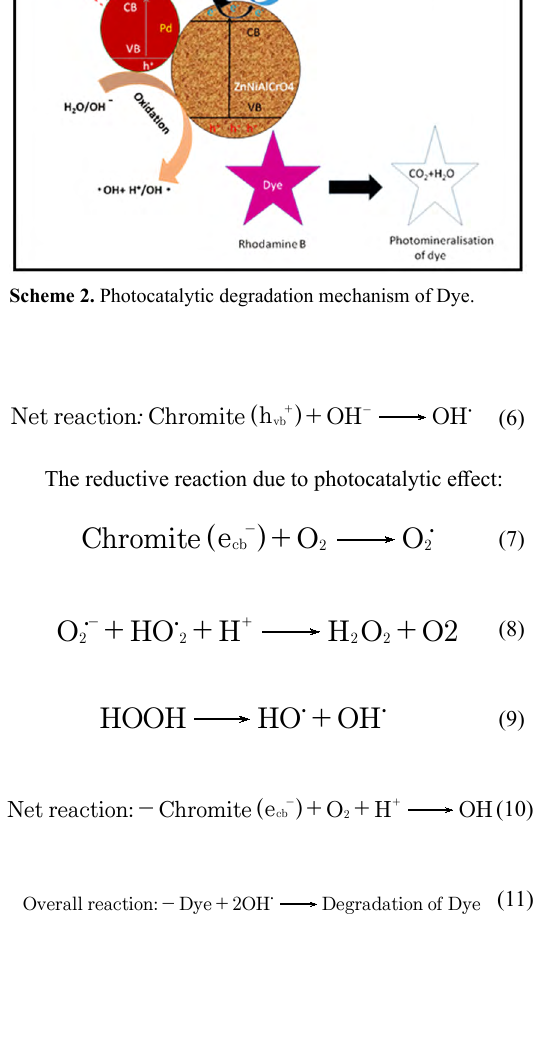
Figure 8. (a) Photocatalytic degradation of Rhodamine B by Zn B by Pd loaded NiAl chromites.